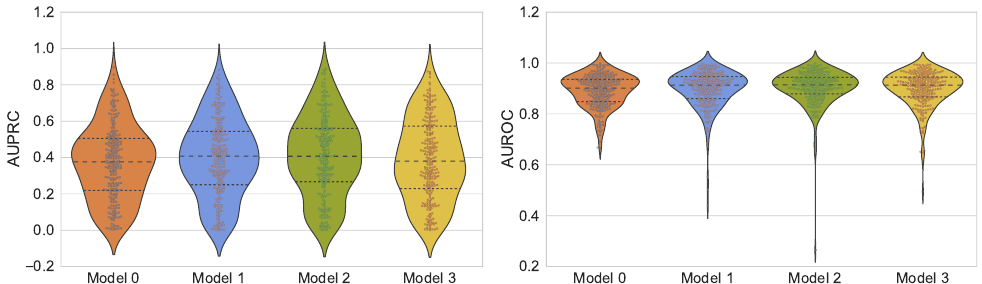
Figure 6. The violin shape represents the distribution of the record-wise (sample) AUPRC and AUROC scores evaluated on the n = 249 held-out test records. The horizontal black lines correspond (from bottom to top) to the 25th percentile (Q 1 ), 50th percentile (Q 2 ), and 75th percentile (Q 3 ), respectively. Each dot represents a sample sleep record score.